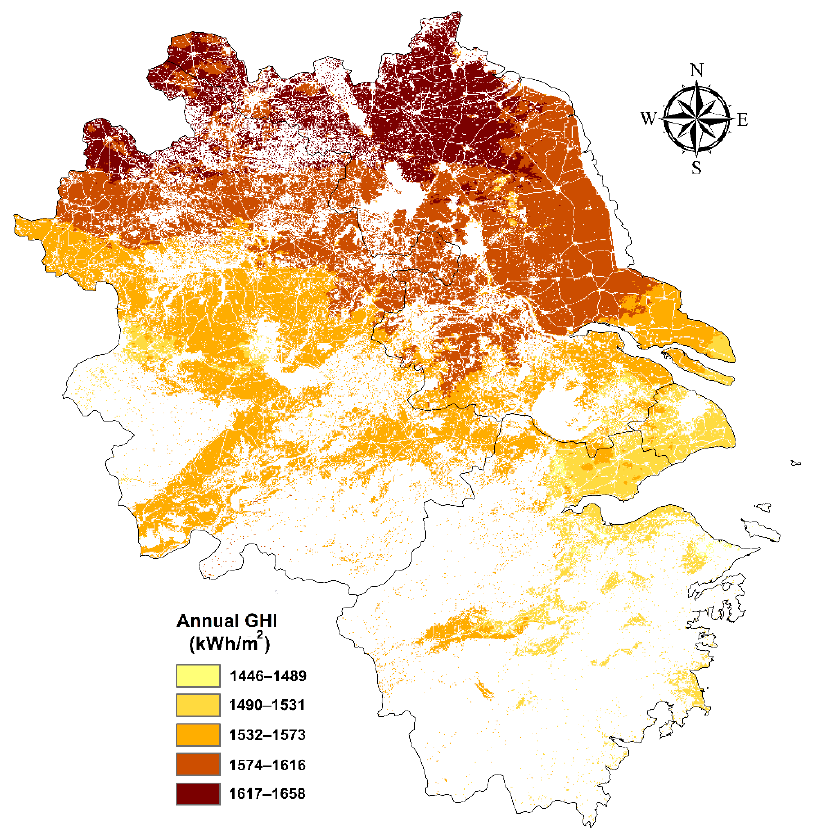
Figure 5. YRDR geographical solar energy potential.